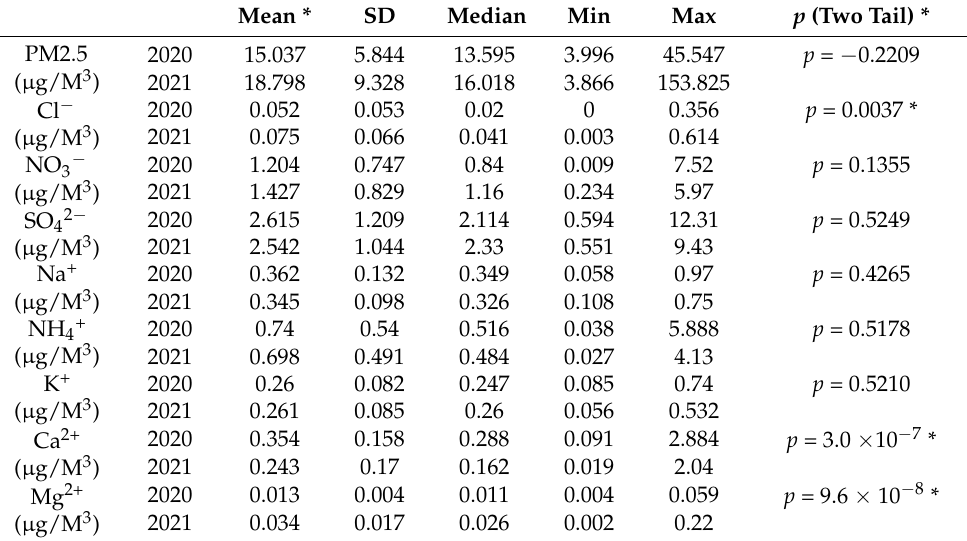
Table 2. Comparison of concentrations of ionic components of PM2.5 in 2020 and 2021.